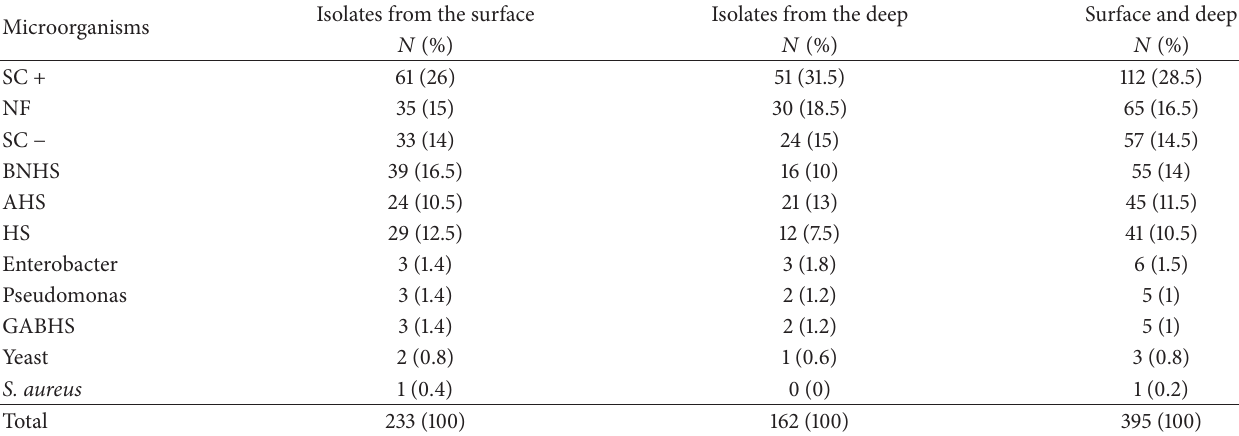
Table 2: The various organisms isolated from the surface and depth of the tonsils of the patients with chronic tonsillitis. Isolates from the surface Isolates from the deep Surface and Microorganisms